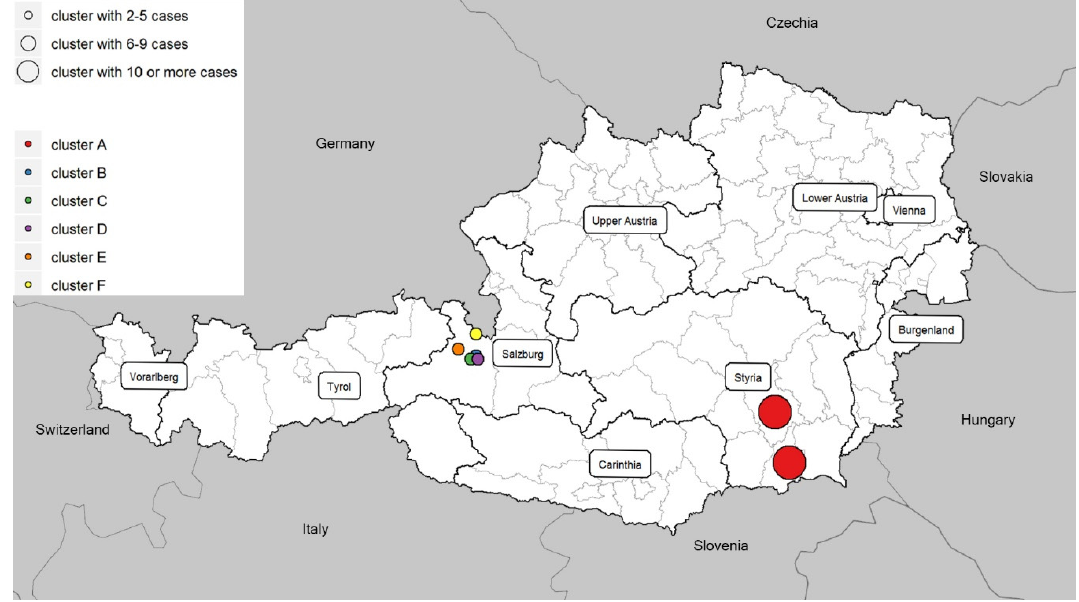
Figure 2. Measles cases according to day of symptom onset and cluster distribution, Austria, January–March 2019 (n = 47).